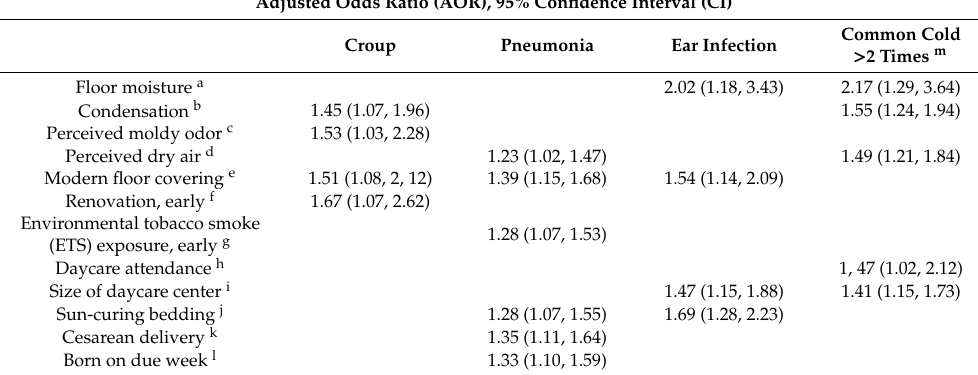
Table 5. Multivariate analyses on associations of respiratory infections among children with home environmental, lifestyle, and biological factors in Tianjin, China.